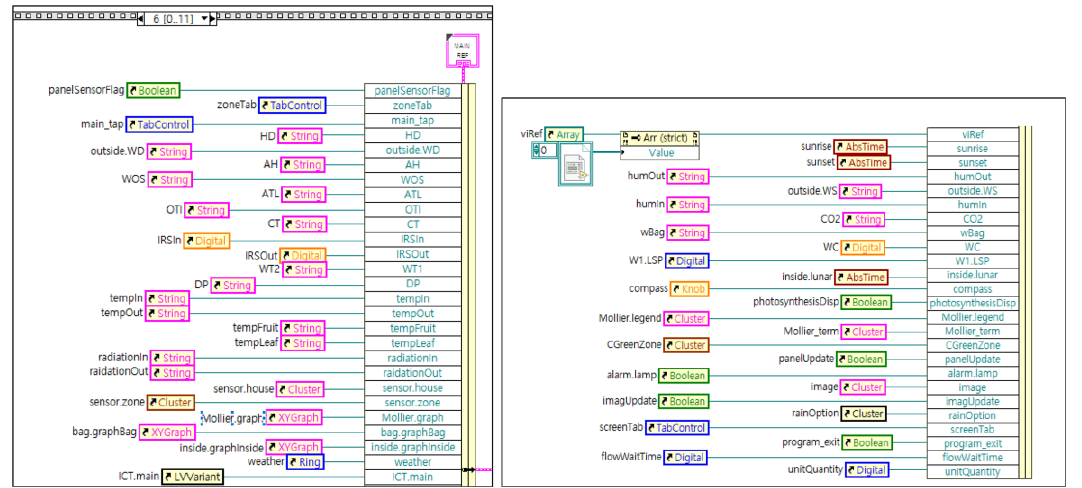
Figure A3. Block diagram of the main software user interface, made in LabVIEW 2017 (32 bit).